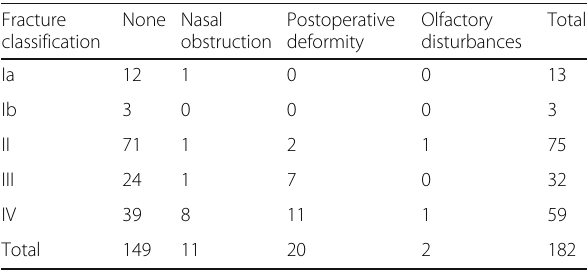
Table 6 Types of complications Fracture classification